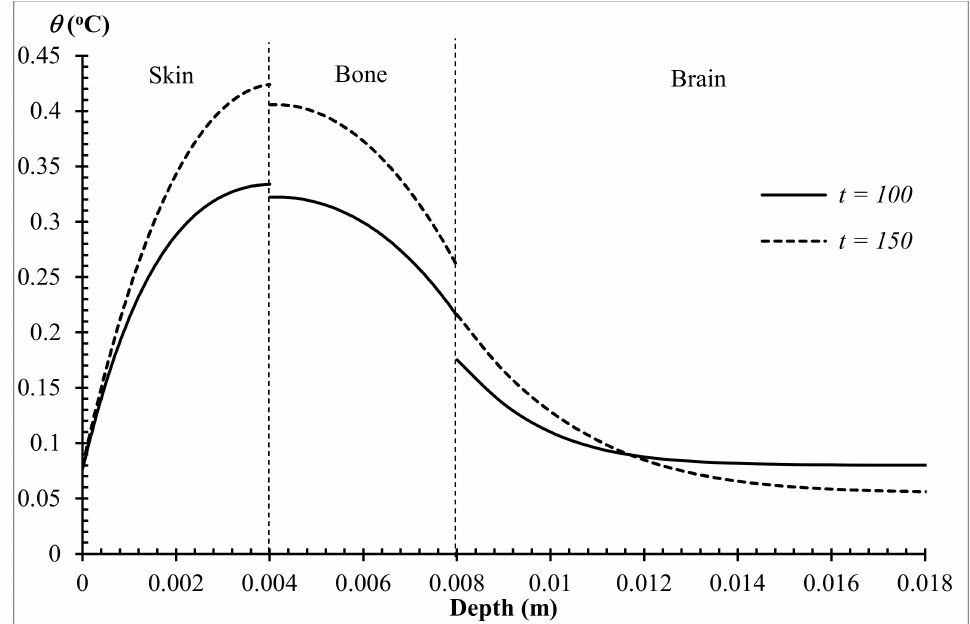
Figure 18. The dynamical temperature increment with various times on an adult’s head.